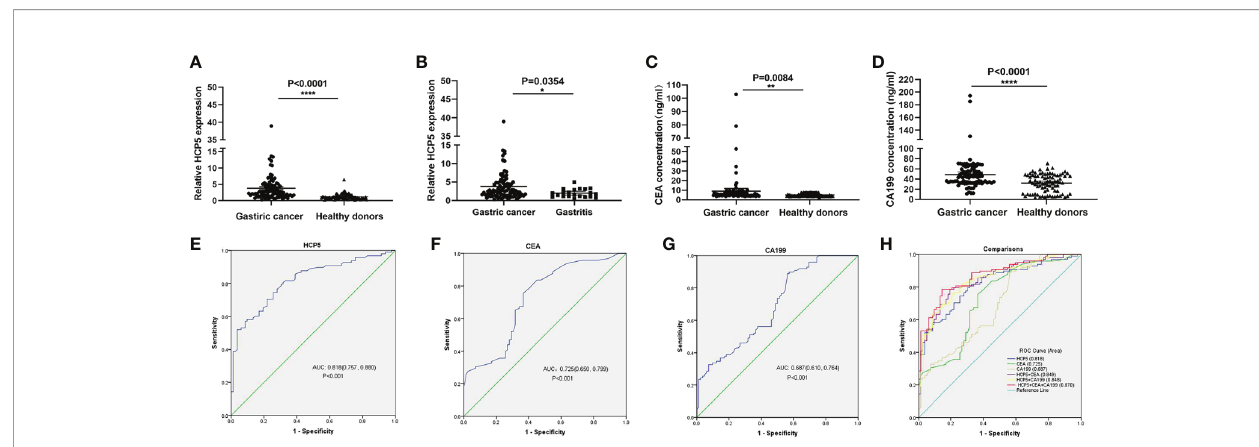
FIGURE 2 | Concentrations of serum HCP5, CEA, and CA199 in GC cases and diagnostic ef fi cacy . (A) Detection of serum HCP5 in GC patients (n=98), healthy donors (n=82). (B) Detection of serum HCP5 in GC (n=98) and gastritis (n=21) patients. (C) The concentrations of serum CEA. (D) The concentrations of serum